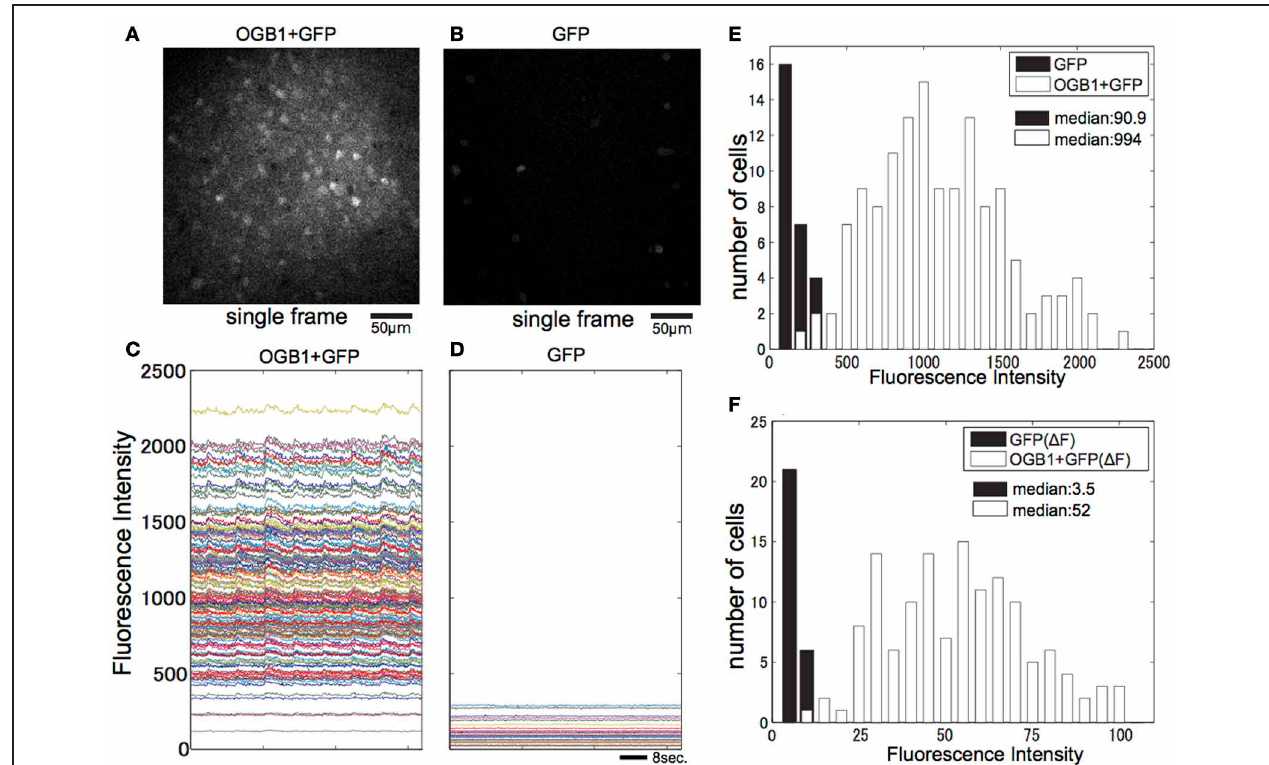
FIGURE 5 | Effect of the GFP signal in GAD67-GFP mice. (A) Single-image frame obtained from GAD67-GFP mouse loaded with OGB-1. (B) Single-image frame obtained from GAD67-GFP mouse in the same condition as (A) . (C) Averaged time courses of all visually responsive neurons in imaged plane shown in (A) while presenting eight direction visual stimulus. (D) Averaged